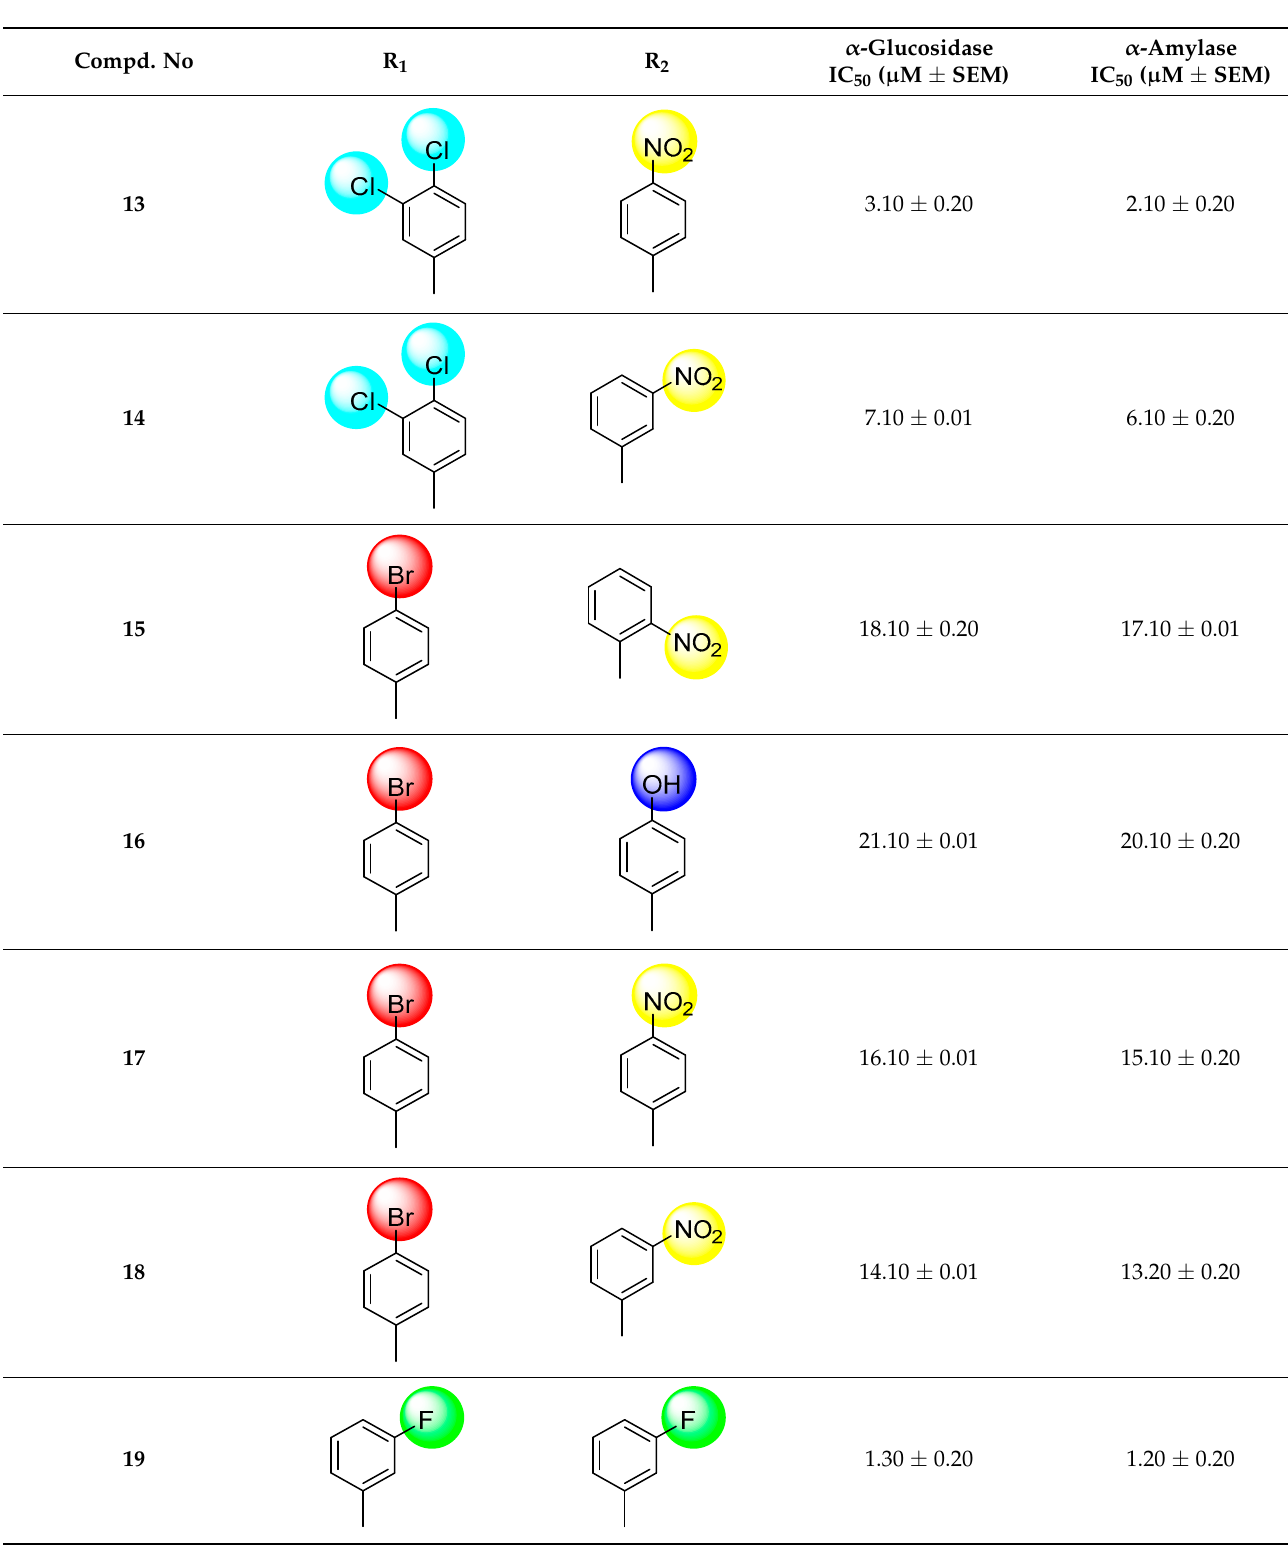
Table 1. Different substituents and α -glucosidase and α -amylase inhibitory activities of benzimid- azole bearing thiosemicarbazone derivatives ( 7–21 ). Table 1. Cont. corresponding to the remaining four carbons of benzimidazole appeared at 121.5 (CH), sponds to active methylene groups attached to sulfur atoms.